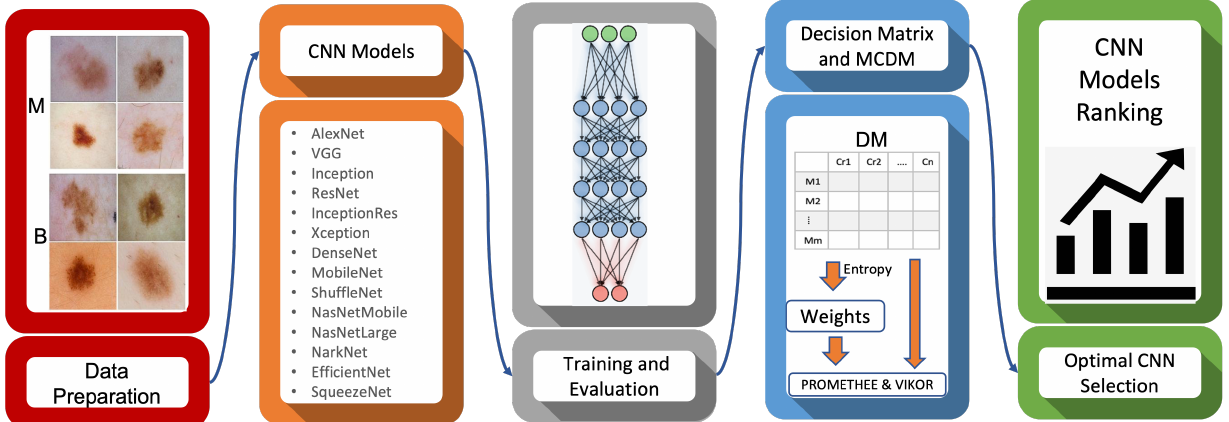
Figure 2. The block diagram of the proposed framework used to benchmark CNN models for melanoma diagnosis. M refers to malignant (melanoma) and B refers to benign